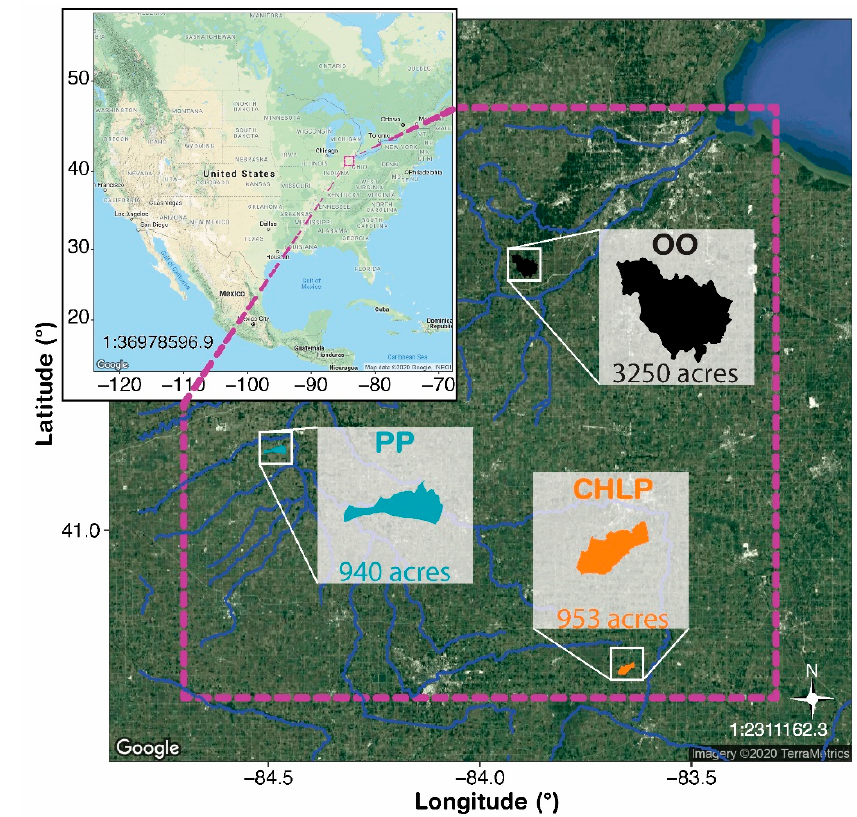
Figure 1. Map of the sampling locations used in the study. The study area was in northwest Ohio in the purple area highlighted on the map in the upper left corner (1:36978596.9 scale). Floodplain sediments were collected from benches formed in agricultural channels in the Oak Openings (OO), Paulding Plains (PP), and Clayey, High-Lime Till Plains (CHLP) Ecoregions as shown in the lower right map (1:2311162.3 scale). Watersheds were delineated using the US Geological Survey StreamStats (USGS) Geographic Information System (GIS) program and are shown for the sampling locations with the watershed area indicated.